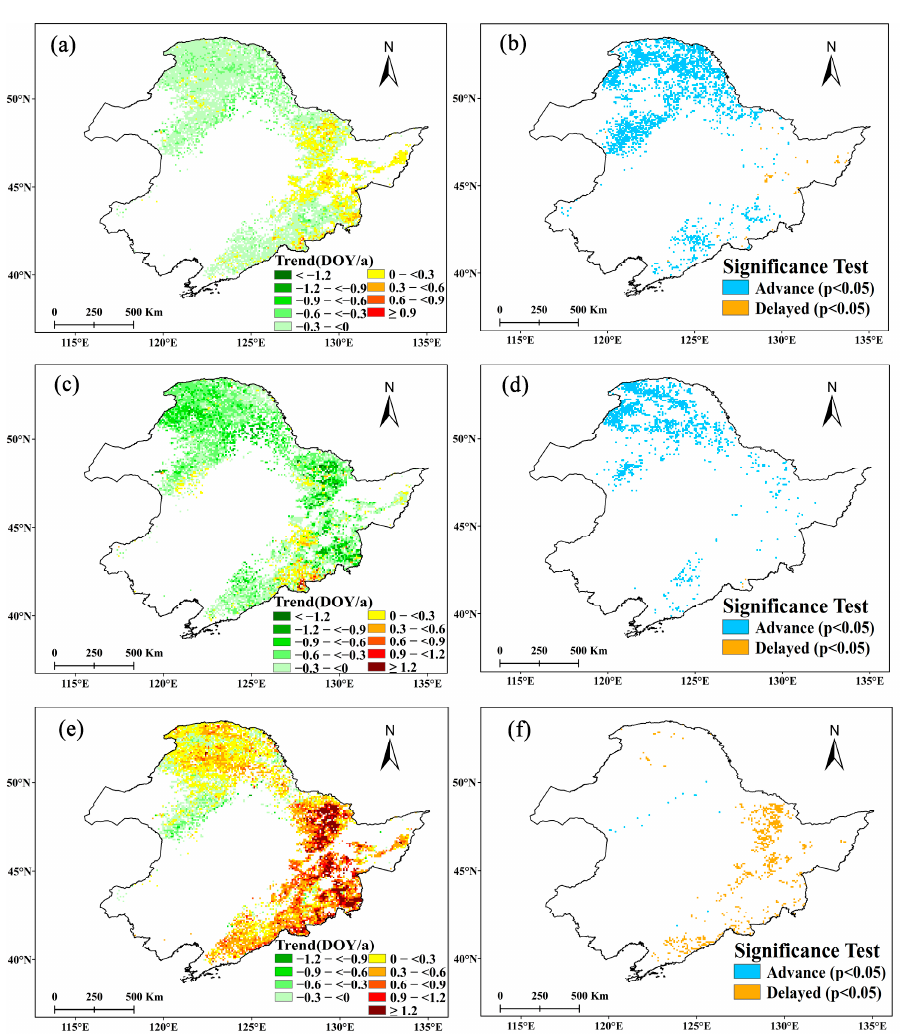
Figure 4. SOS trends (left) and significance test (right) in Northeast China forests, during the entire study period (1982–2013, ( a , b )), the early rapid warming period (1982–1998, ( c , d )) and the short-term slowdown (1998–2013, ( e , f )).